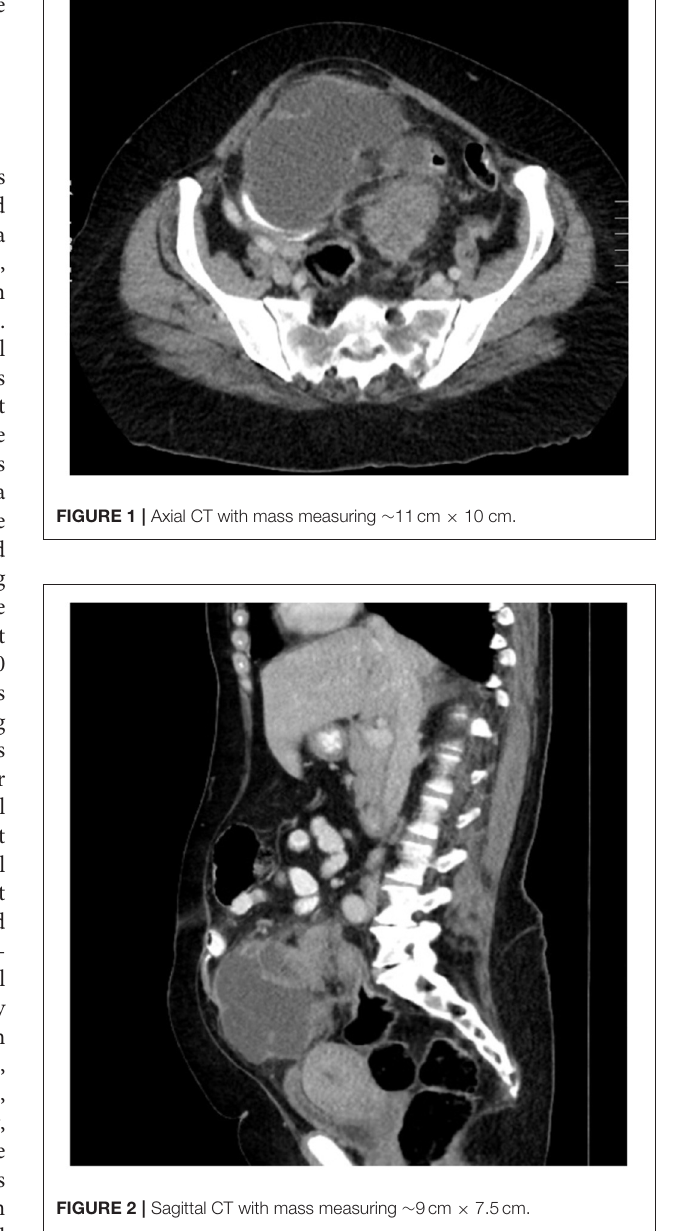
FIGURE 2 | Sagittal CT with mass measuring ∼ 9cm ×